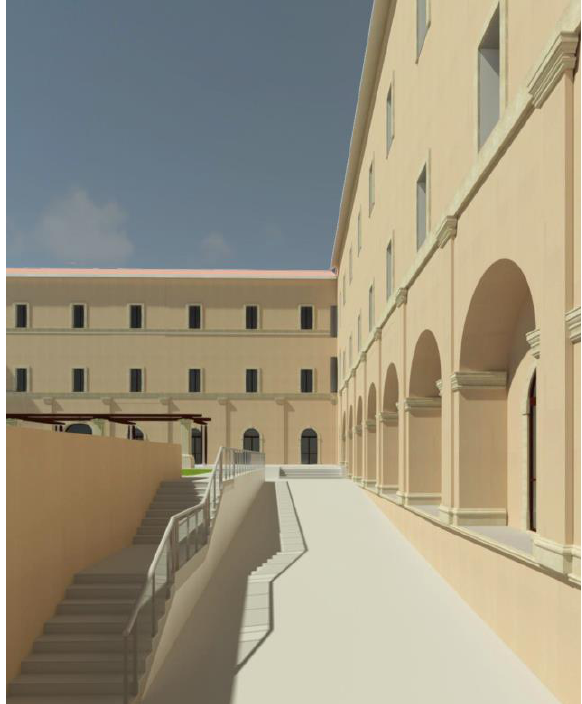
Figure 1. BIM model of Camponeschi palace, L’Aquila (16th century): rendered view of the